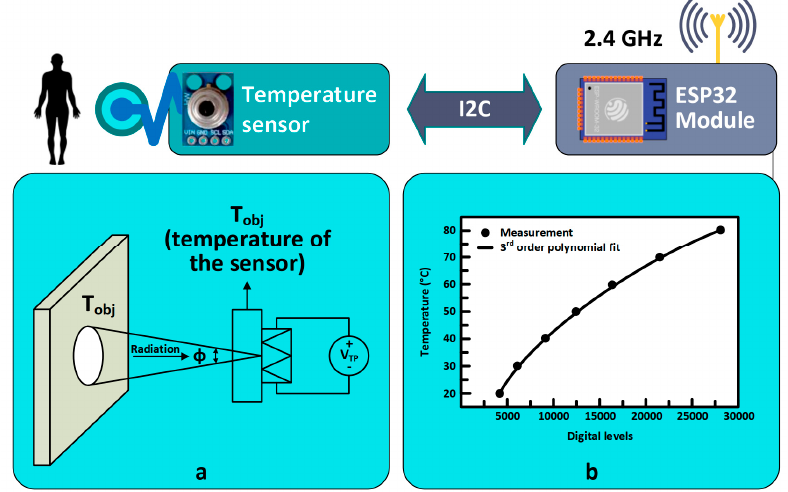
Figure 8. IoT nodes for estimating body temperature: ( a ) Conversion of the reflected radiation into voltage which refers to temperature values ( b ) Interpretation of digital signals into temperature values (inspired from [30,39]).